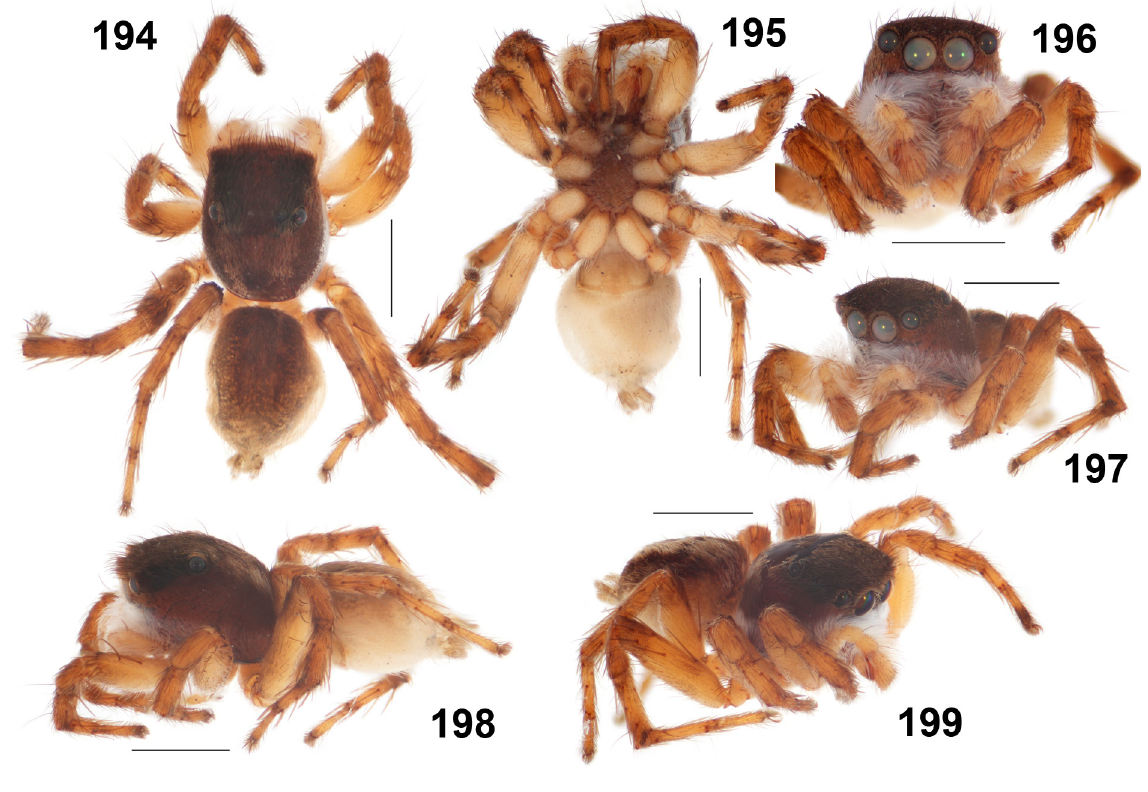
Figs 194–199. Manzuma tanzanica gen. et sp. nov., holotype, ♂, general appearance. Scale bars: 1